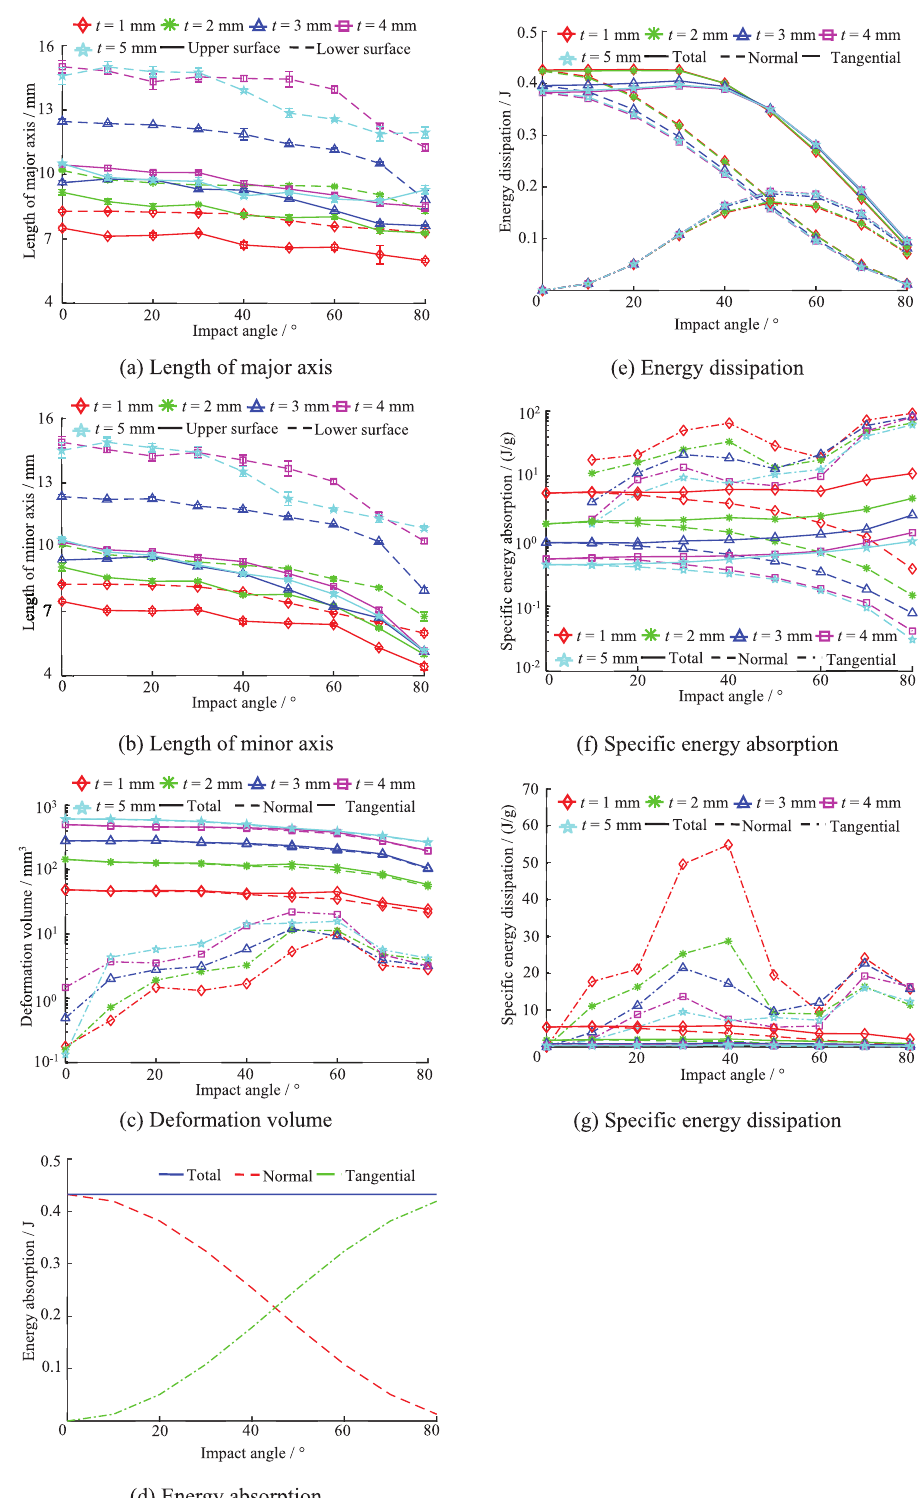
Fig. 3. Geometrical characteristic sizes of contact surfaces, deformation volumes and speci fi c energy parameters at different impact